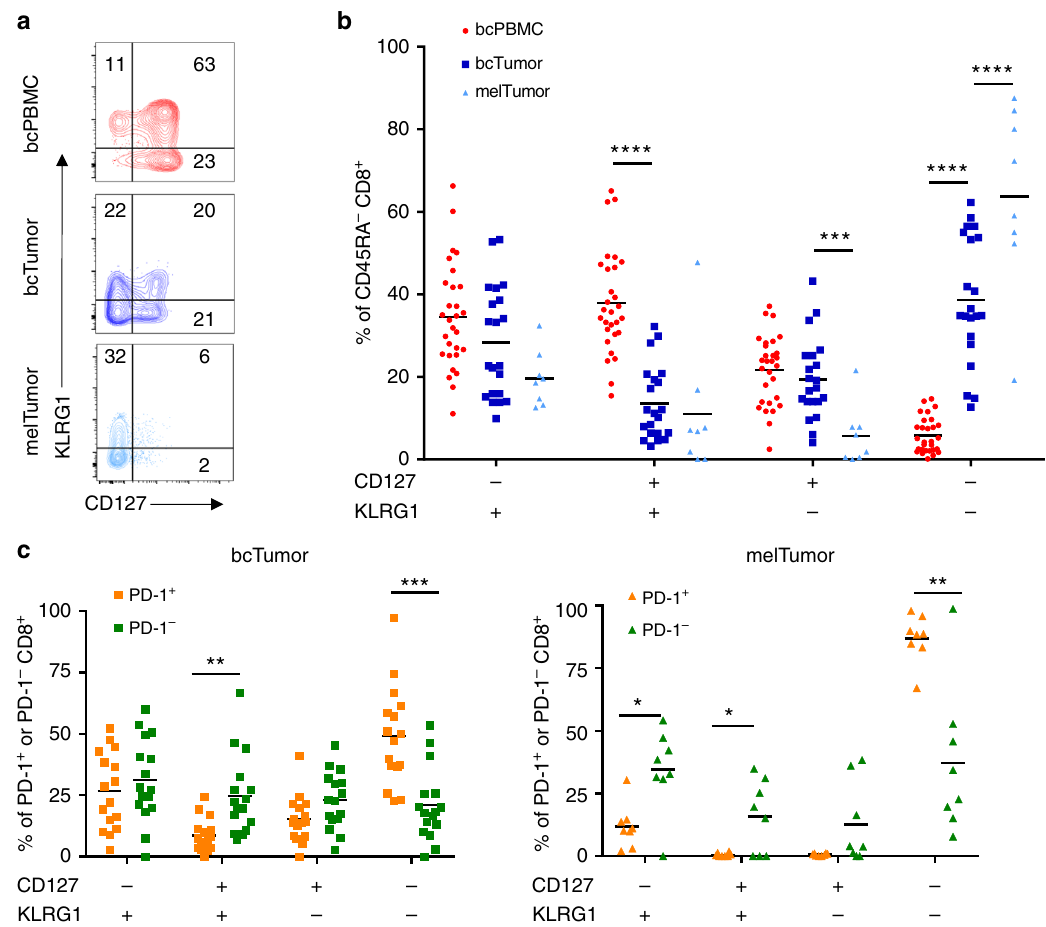
Fig. 4 Higher frequencies of terminally differentiated CD127 − KLRG1 − CD8 + TILs are present in melanoma tumors than breast tumors. a CD8 + T cells from bcPBMCs, bcTumor, and melTumor were assessed for expression of CD127 and KLRG1 by fl ow cytometry as shown in representative contour plots. b Graph depicts percentage of non-naive CD45RA − CD8 + T cells that express a given expression pattern of CD127 and KLRG1. c Graphs depict the proportions of PD-1 + and PD-1 − CD8 + T cells from bcTumor and melTumor with a given expression of CD127 and KLRG1. Each symbol represents data from a unique patient sample. Signi fi cance was calculated using one-way ANOVA and Holm – Sidak multiple comparison tests; * p < 0.05; ** p < 0.01; *** p < 0.001; **** p <